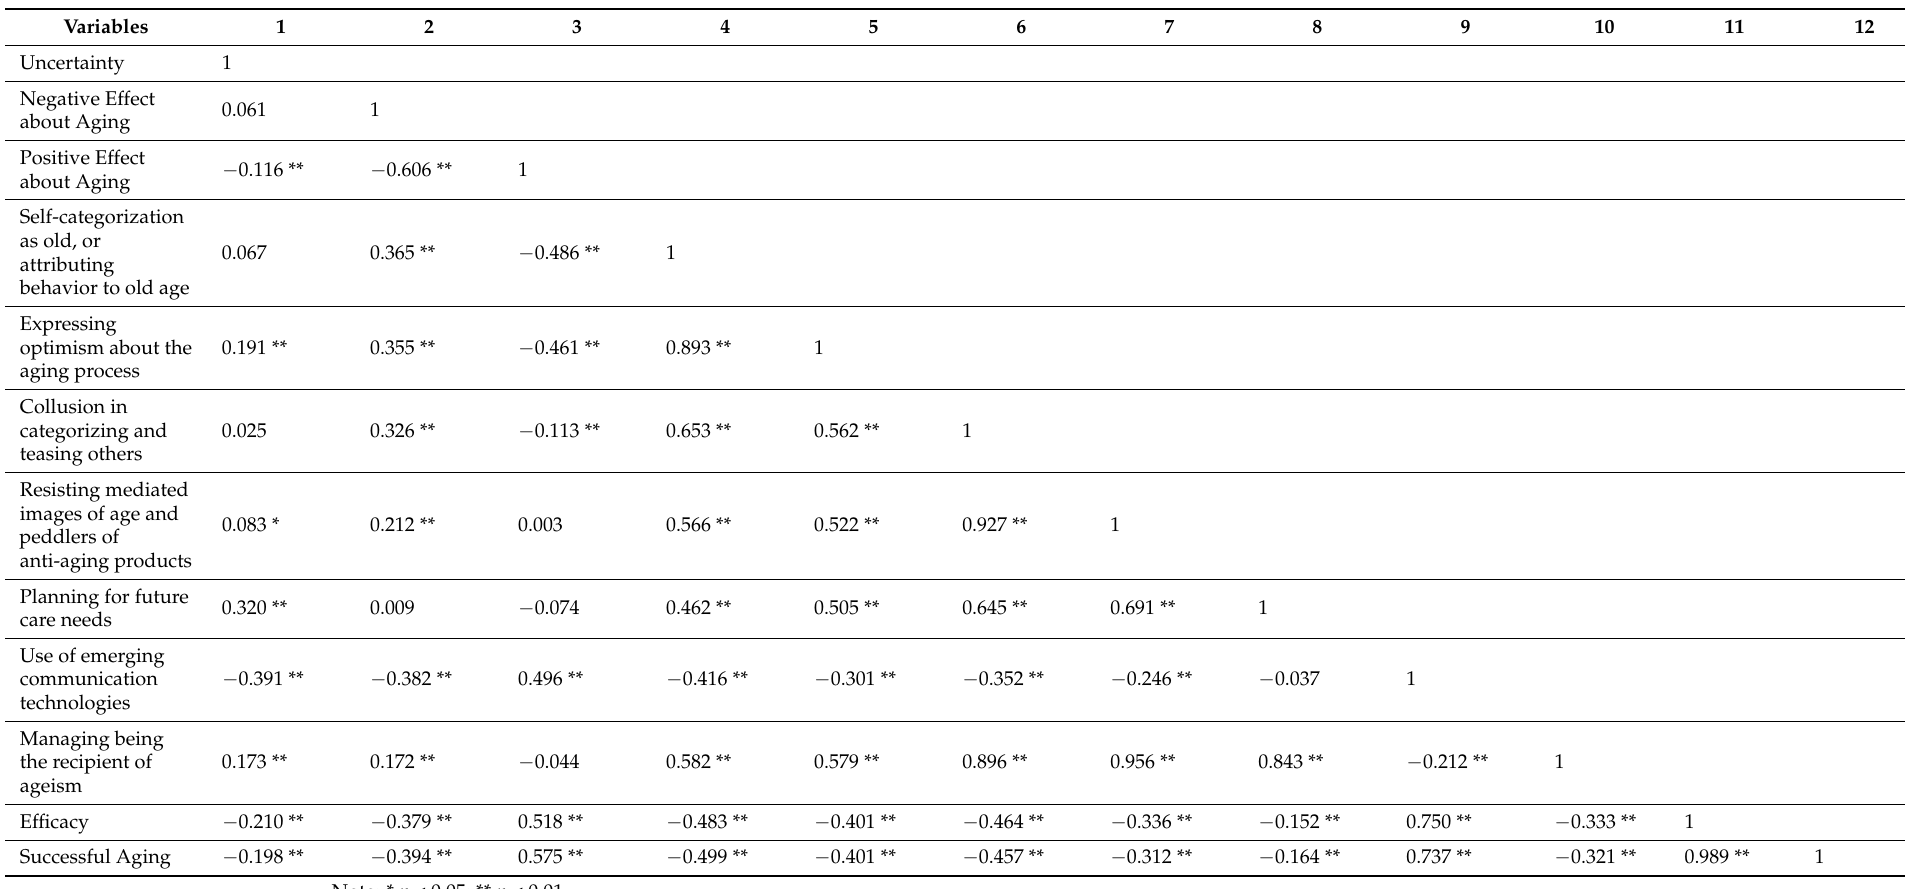
Table A3. Correlations between